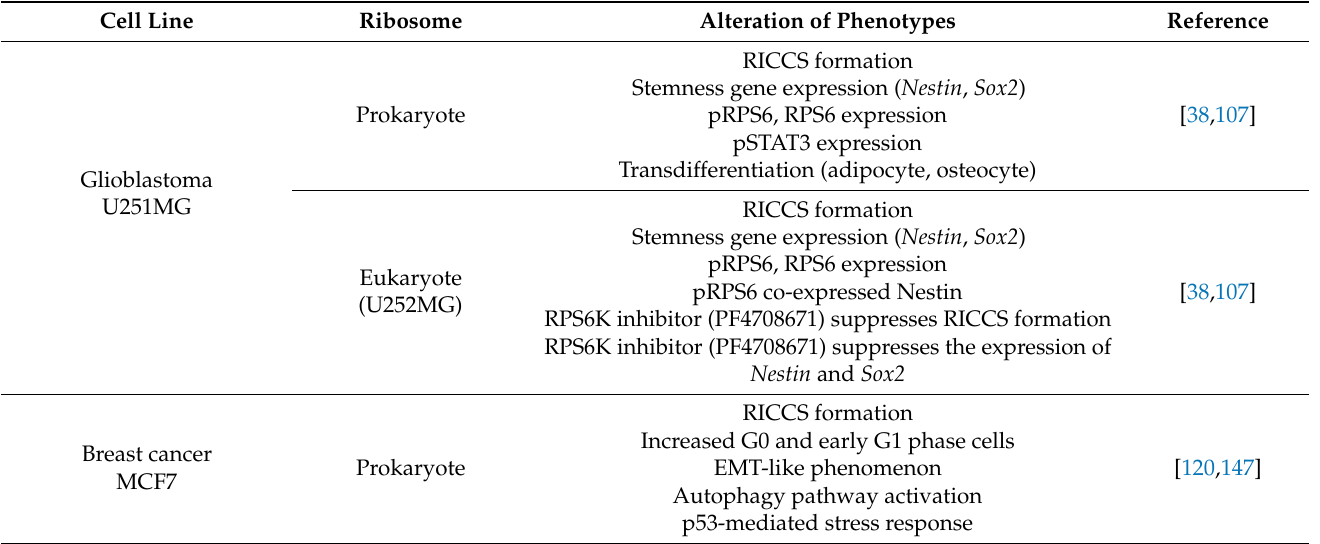
Table 2. Ribosome incorporation into cancer